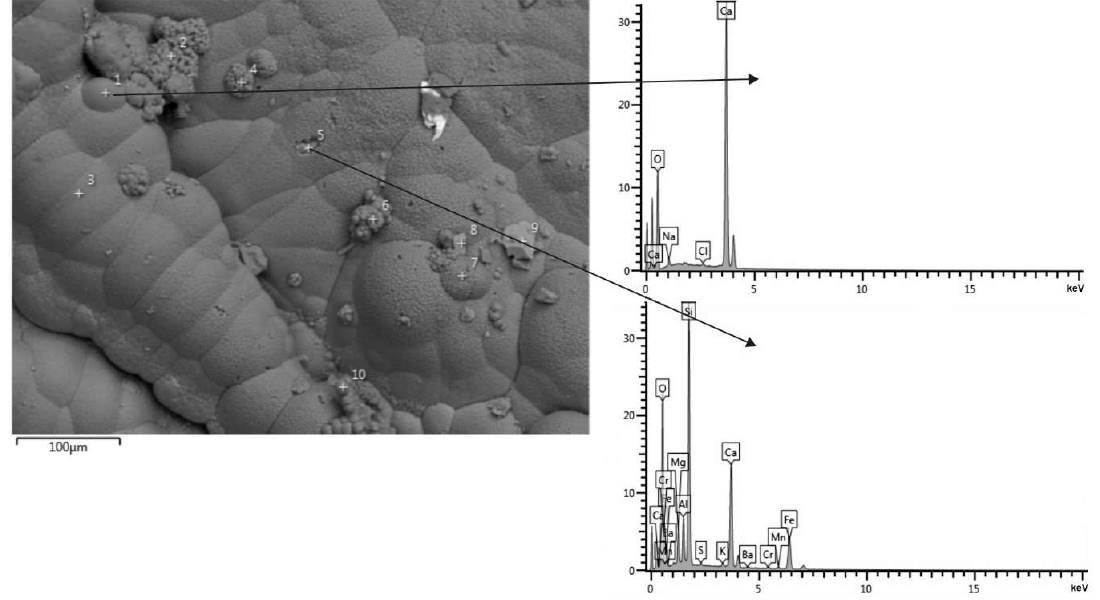
Figure 5. EDS-spectra representing main morphological elements of studied neoformations and particles (inclusions) of detrital origin.